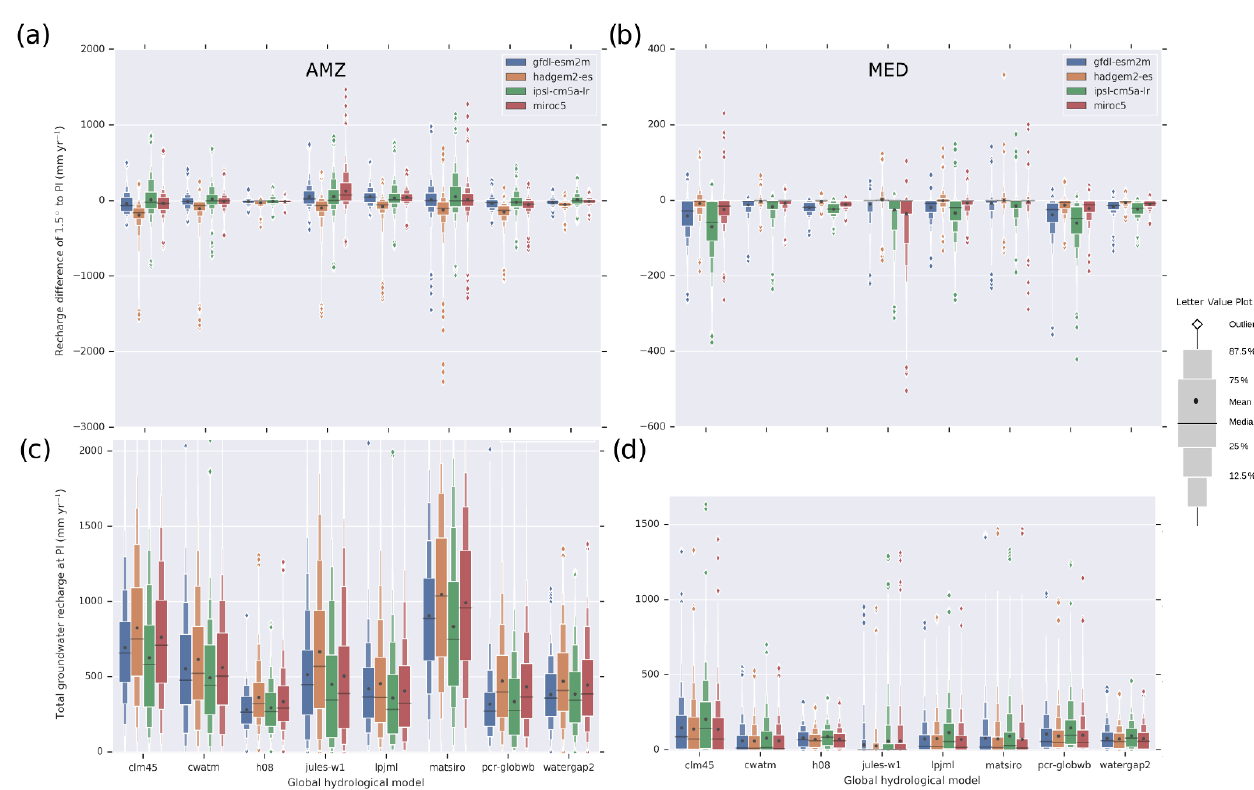
Figure 4. Letter-value plot (Hofmann et al., 2017) of absolute changes in GWR in 0.5 ◦ grid cells (mmyr − 1 ) at 1.5 ◦ C GW compared to PI (a, b) and absolute PI GWR (mmyr − 1 ) (c, d) for the Amazon (a, c) and the southern Europe/Mediterranean (b, d) SREX region (for all other regions and GW levels (2, 3 ◦ C), see the Supplement). No statistical test is applied, and all grid cells inside a region are included. Each box may include multiple simulations with different